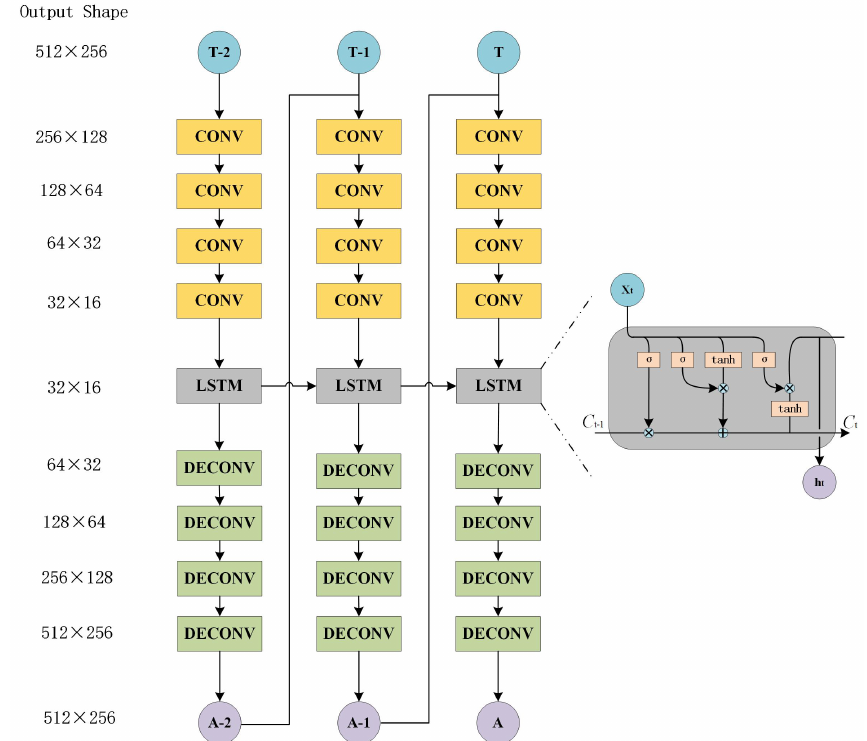
Figure 7. Attentive